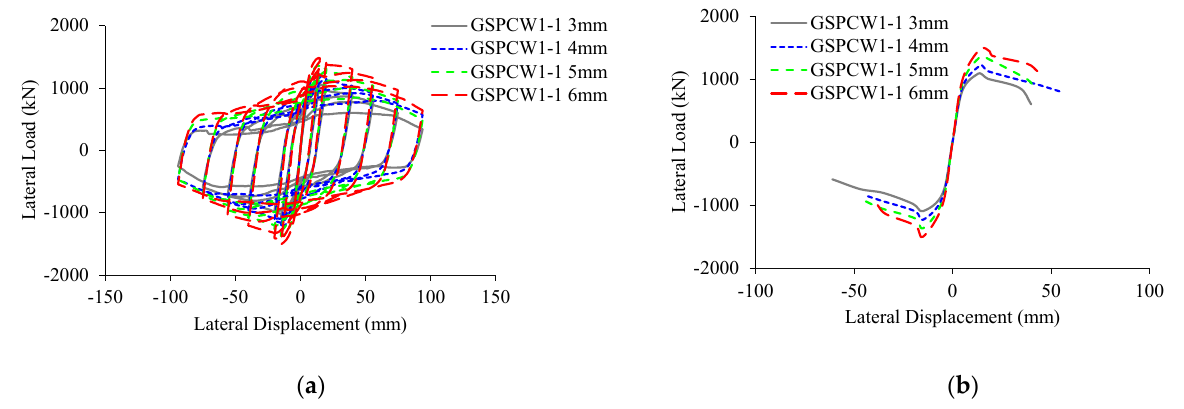
Figure 6. Influence of steel ratio: ( a ) load–displacement hysteresis curves, and ( b ) skeleton curves.